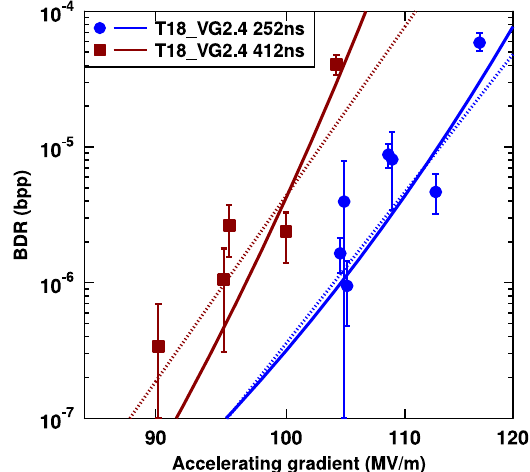
FIG. 4. Measured dependences of R (in units of breakdown BD per pulse, bpp) versus electric field for the T18 accelerating structure [33,43] and fits of our model (solid lines) as well as power laws (dashed lines) to the data.